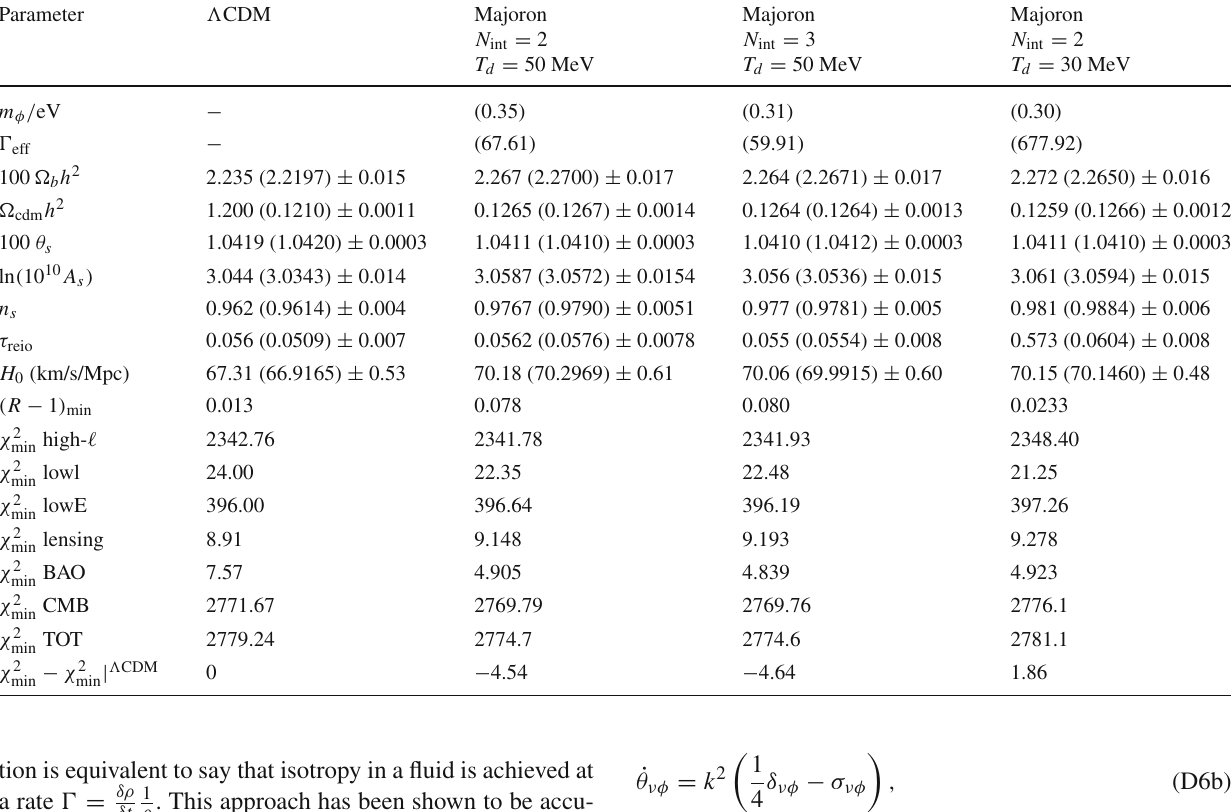
Table 1 Mean (best-fit) values with ± 1 σ errors of the cosmological parameters reconstructed from our combined analysis of Planck2018+BAO data in each scenario. Note that the 2 σ lower limit on (cid:15) eff for each model (from left to right) corresponds to 0.089, 0.113, and 0.154